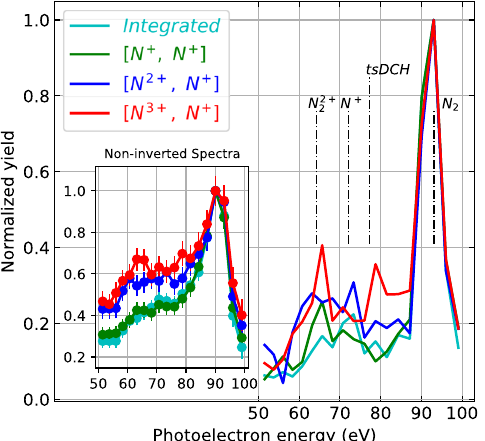
Figure 3. Ion-ion-coincidence-channel-resolved photoelectron kinetic energy spectra. The spectra before inversion (i.e. radial distributions, converted to energy units, of the two-dimensional projections of the momentum distributions) are shown in the inset. Vertical dashed lines mark the calculated photoelectron line positions for various molecular and atomic states of N 2 (adapted from Ref. 26 ). The vertical line labeled N + 3 1 4 1 1 corresponds to the transition [ P (2p − ) P (1s − 2p − →